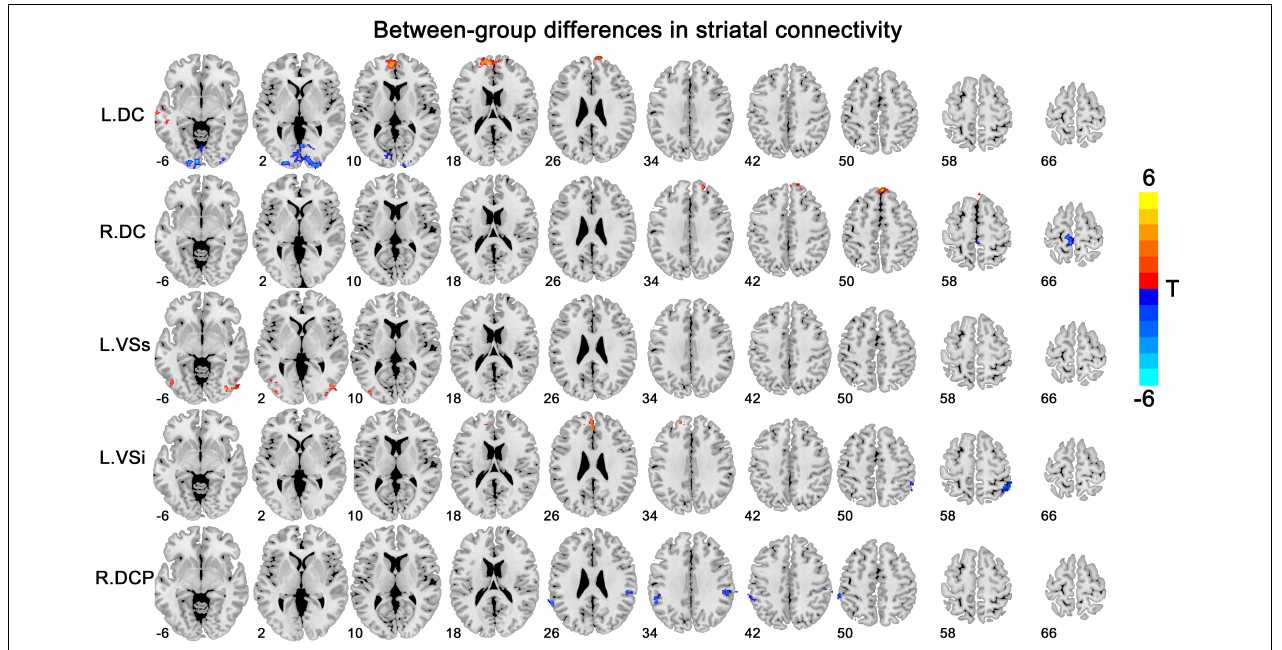
FIGURE 2 | Between-group differences in striatal connectivity. DC, dorsal caudate; VS, ventral striatum; DCP, dorsal caudal putamen. The red colors indicate increased connectivity in primary insomnia patients compared with the healthy controls, while the blue colors indicate contrary connectivity.